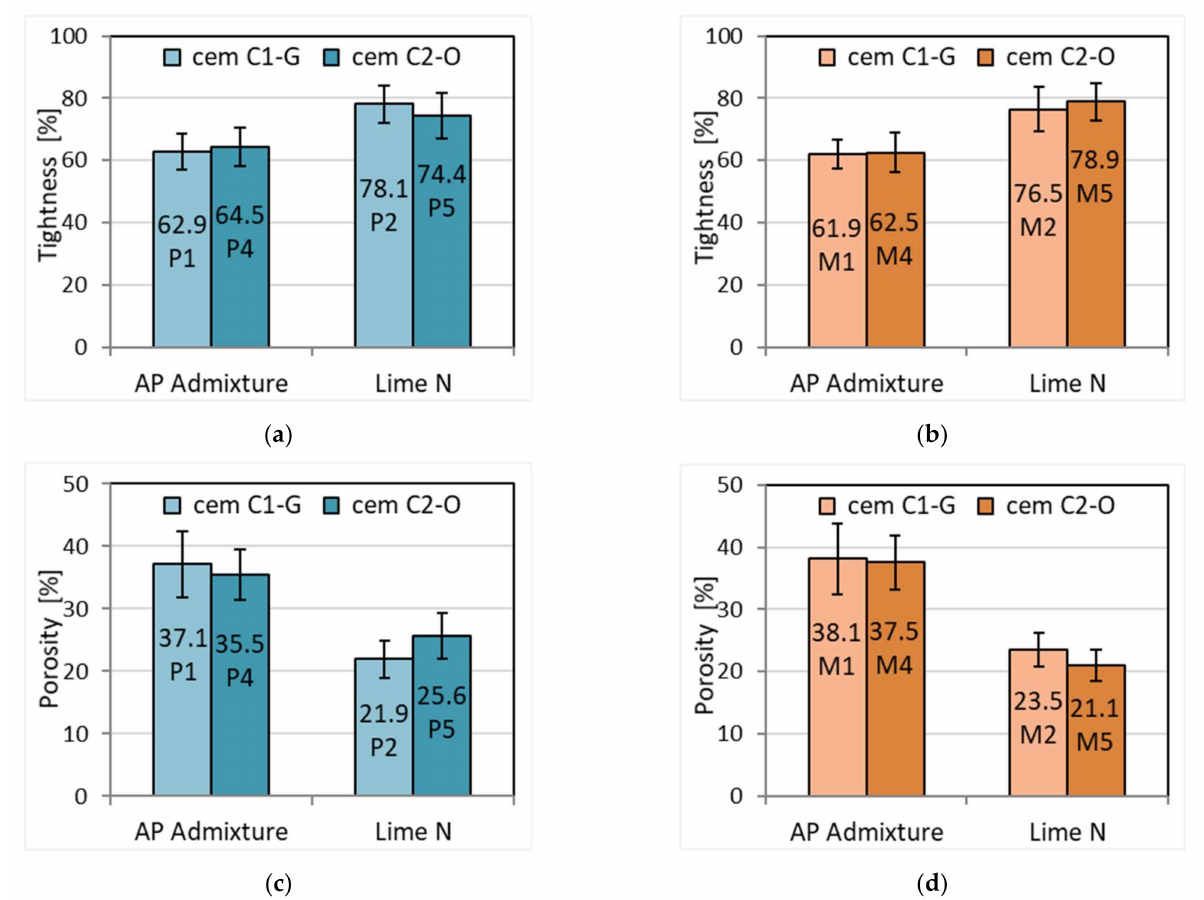
Figure 5. Impermeability and porosity of plasters ( a , c ) and masonry mortars ( b , d ).